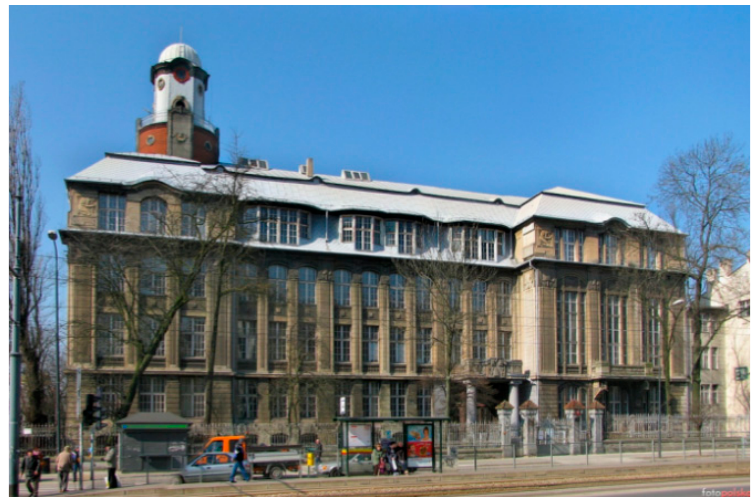
Figure 3. The view of the eastern facade of the building, then the Faculty of Philosophy of the University of Ł ód ź ; 2015 [16].